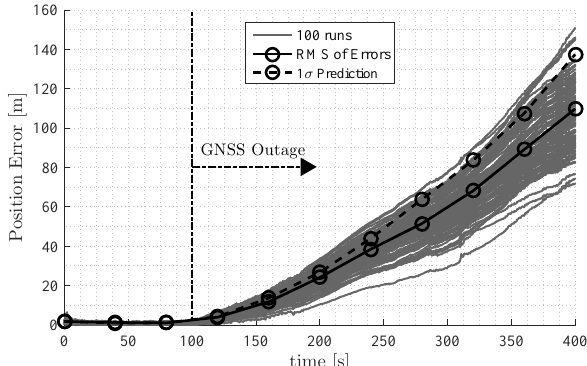
Figure 5: Position errors for all the 100 Monte Carlo runs Figure 6 depicts the empirical RMS of attitude errors for all the 100 runs, with associated predicted values of confidence ( 1 σ ).